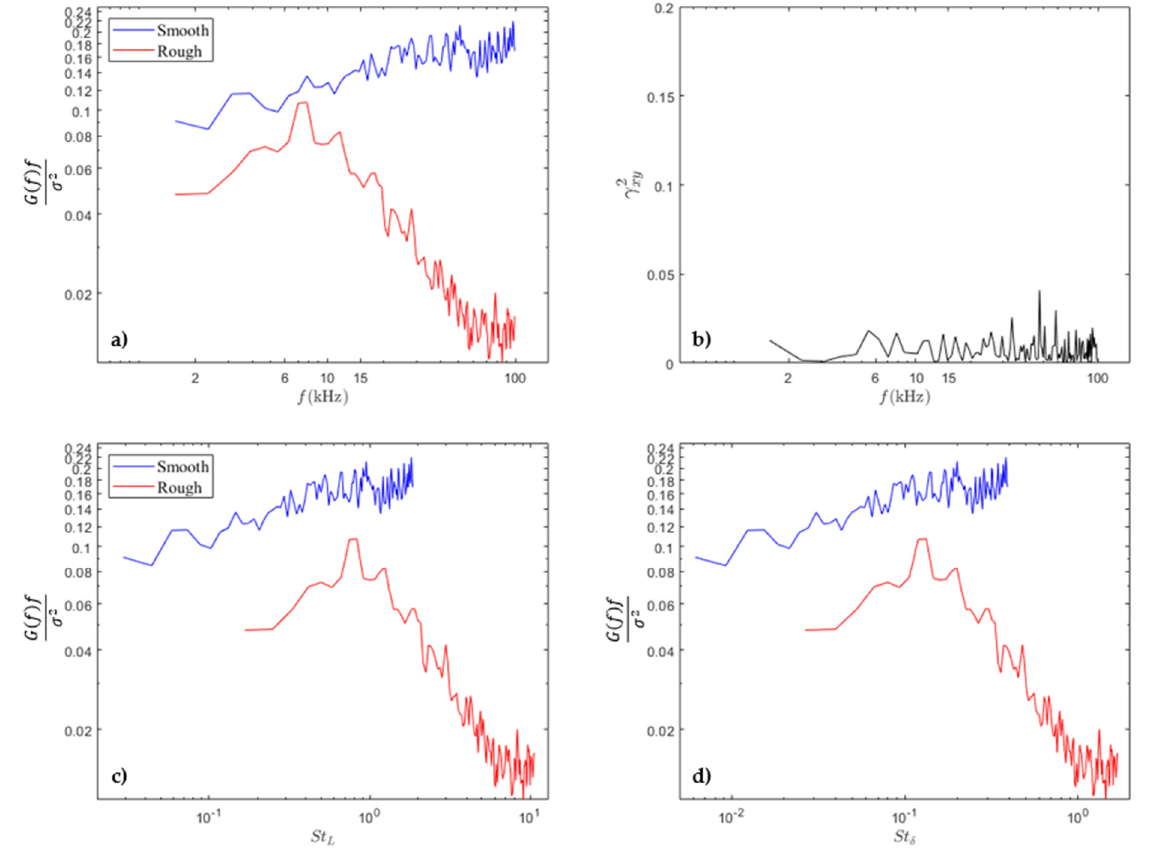
Figure 9. ( a ) Power spectral density of shock location versus frequency, ( b ) coherence for rough and smooth surface, ( c ) power spectral density of shock location versus Strouhal number (intermittent length scaling), ( d ) power spectral density of shock location versus Strouhal number (boundary layer thickness scaling).